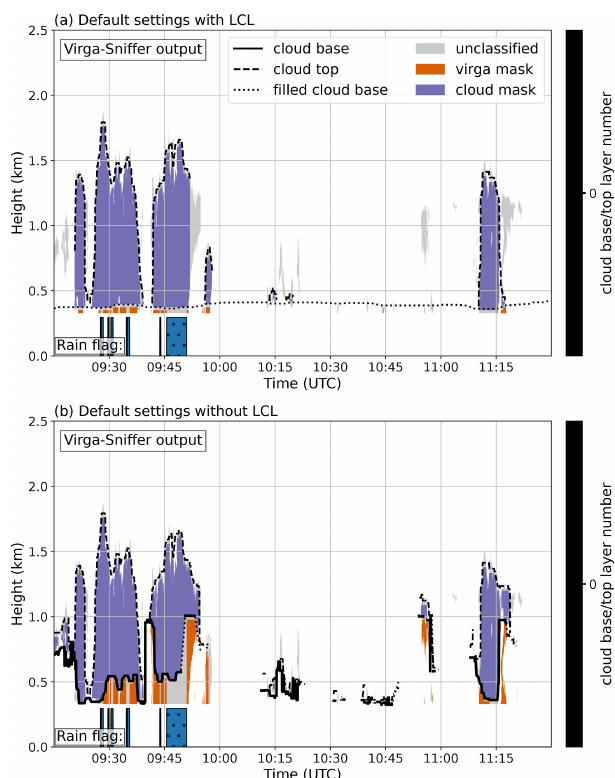
Figure B1. Virga-Sniffer output from 28 February 2020 with (a) and without (b) optional LCL